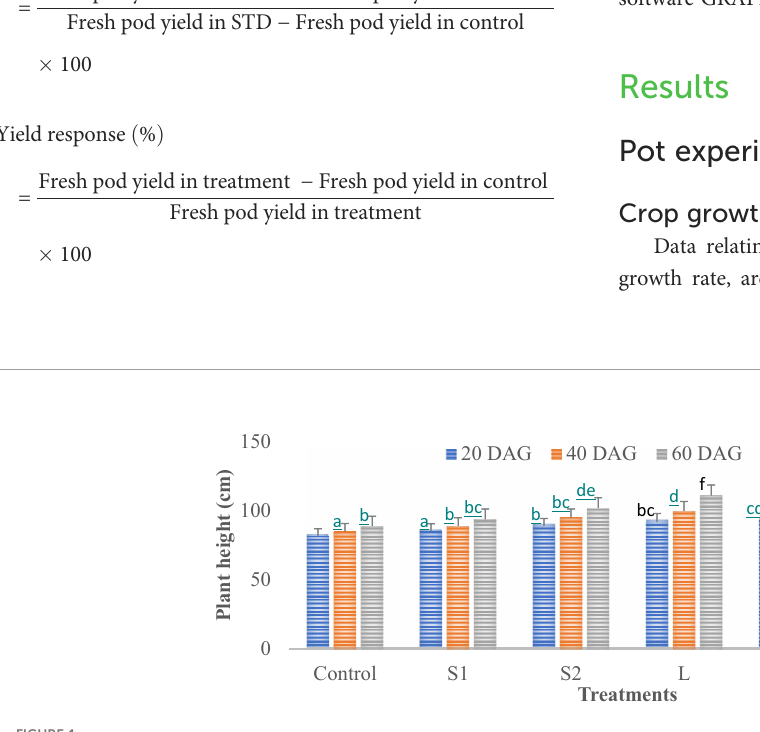
FIGURE 1 In fl uence of Rhizobium strains inoculation on plant height of French bean. T-shaped bar at the top of each bar indicates standard error (SE), and different letters on top indicate statistical difference (Duncan ’ s multiple-test range), p =